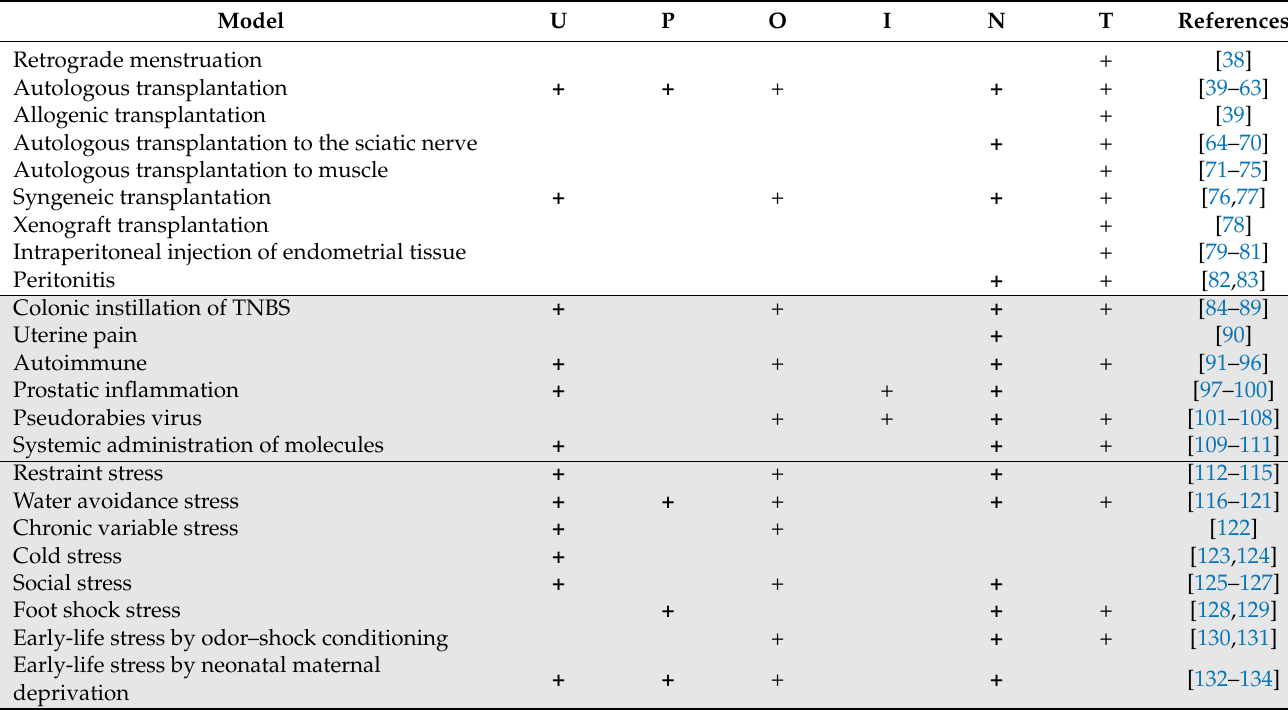
Table 2. Rodent models used recently to study EPS (white background) and CPBPS (grey background). The animals’ characteristics are organized according to their similarity to patients’ symptoms and signs in each UPOINT